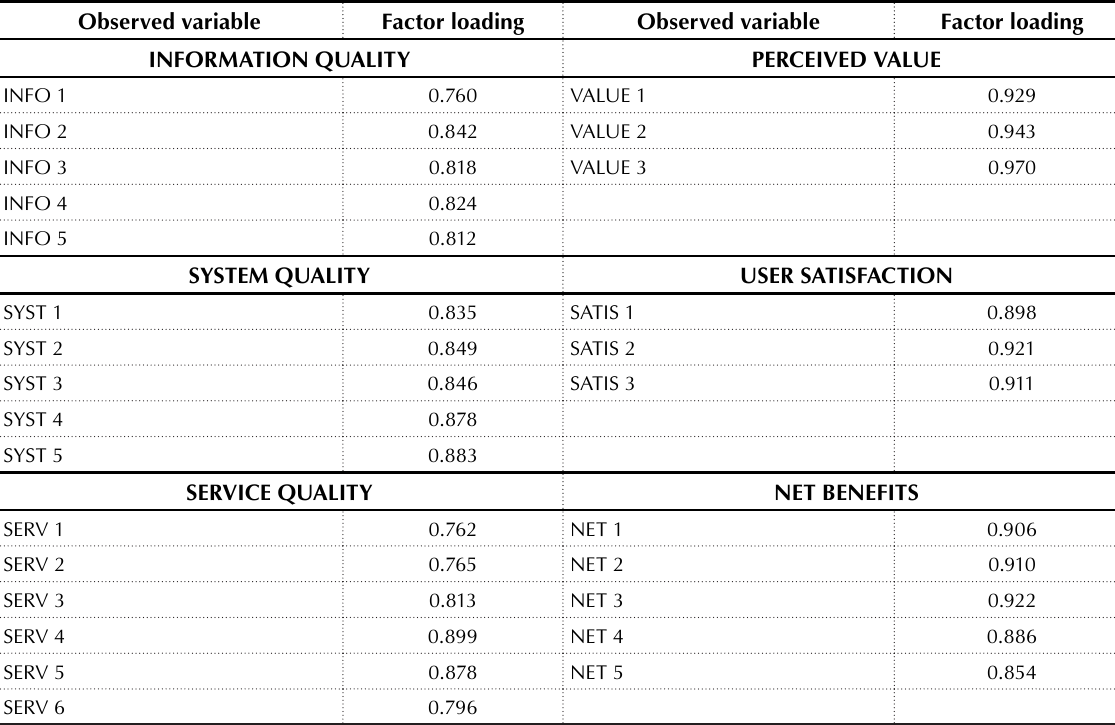
Table 1. Value of factor loading the observed variable Observed